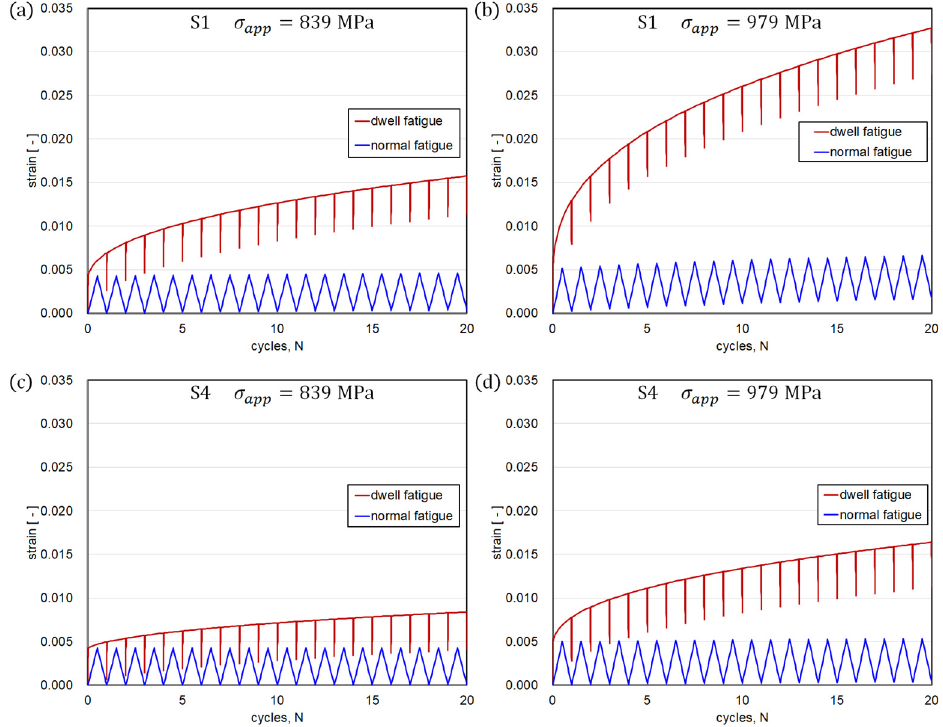
Figure 4. Strain evolutions under normal and dwell fatigue with different stress magnitudes. Specimen S1 under ( a ) 839 MPa and ( b ) 979 MPa; specimen S4 under ( c ) 839 MPa and ( d ) 979 MPa.